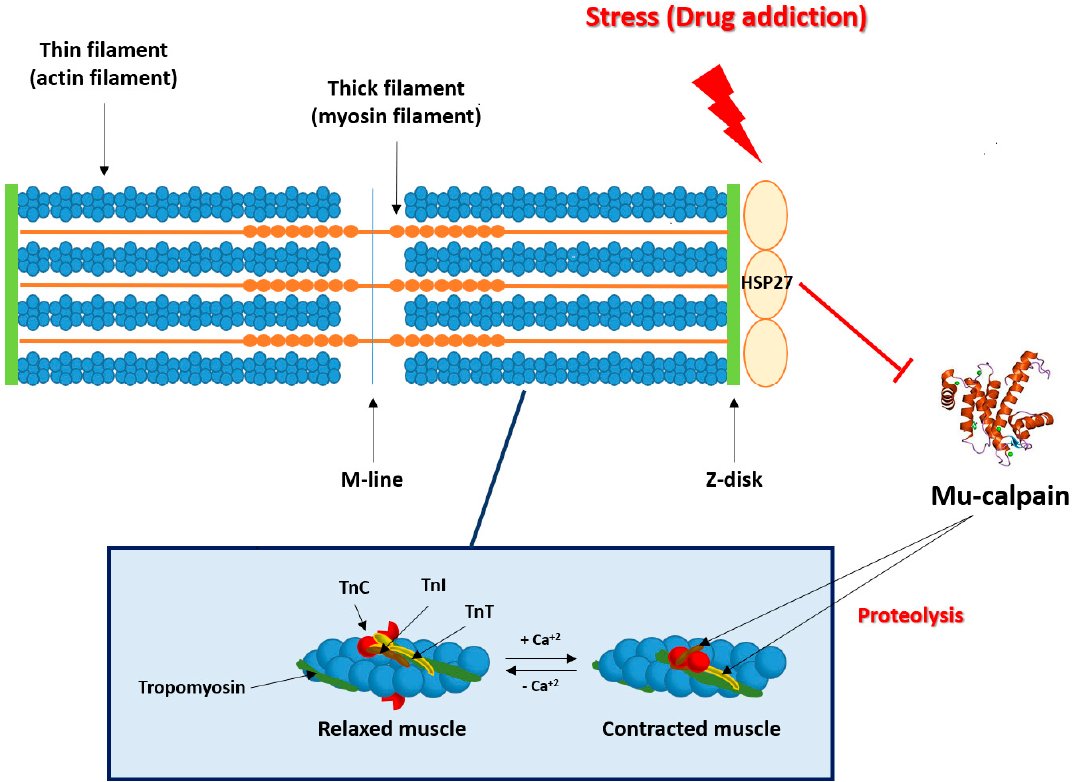
Figure 2. During stress situations, like drug addiction, HSP-27 functions as an excellent cardioprotective protein due to its properties as a chaperone and also in the stabilization of actin filaments. In these situations, HSP-27 is translocated to the Z bands in order to stabilize the actin myofilaments, protecting its degradation. During morphine withdrawal, HSP-27 could protect cardiac troponin T (cTnT) from µ-calpain degradation, whose expression is increased during withdrawal symptoms.